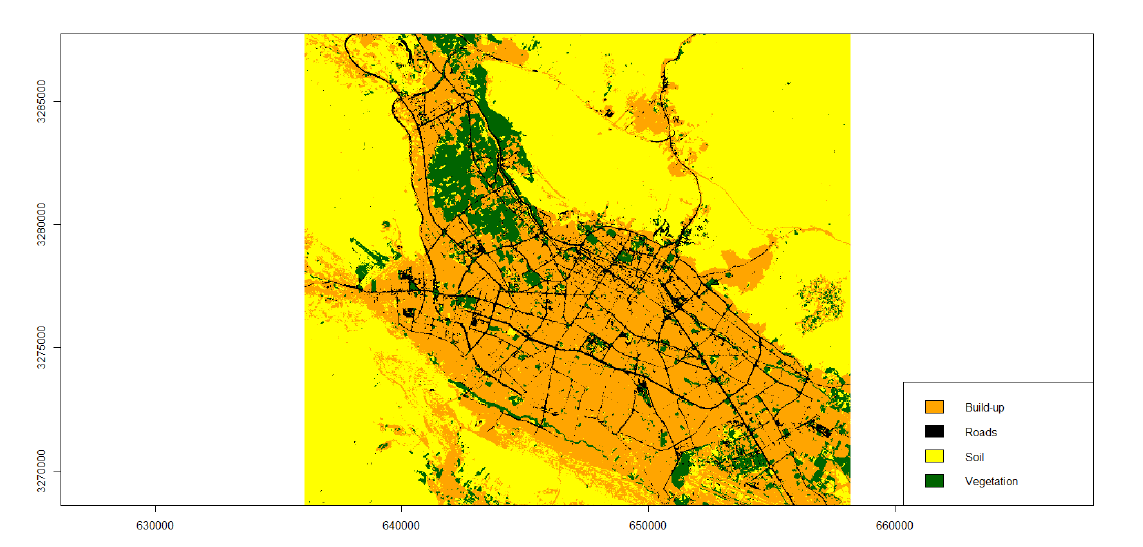
Figure 4. Image classification using SVM classification technique within R programming language.